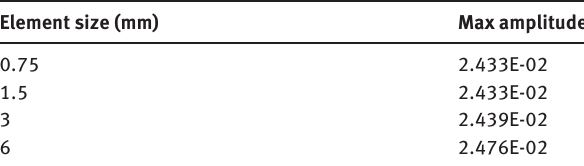
Figure 2: Element size and convergence study for undamaged beam.